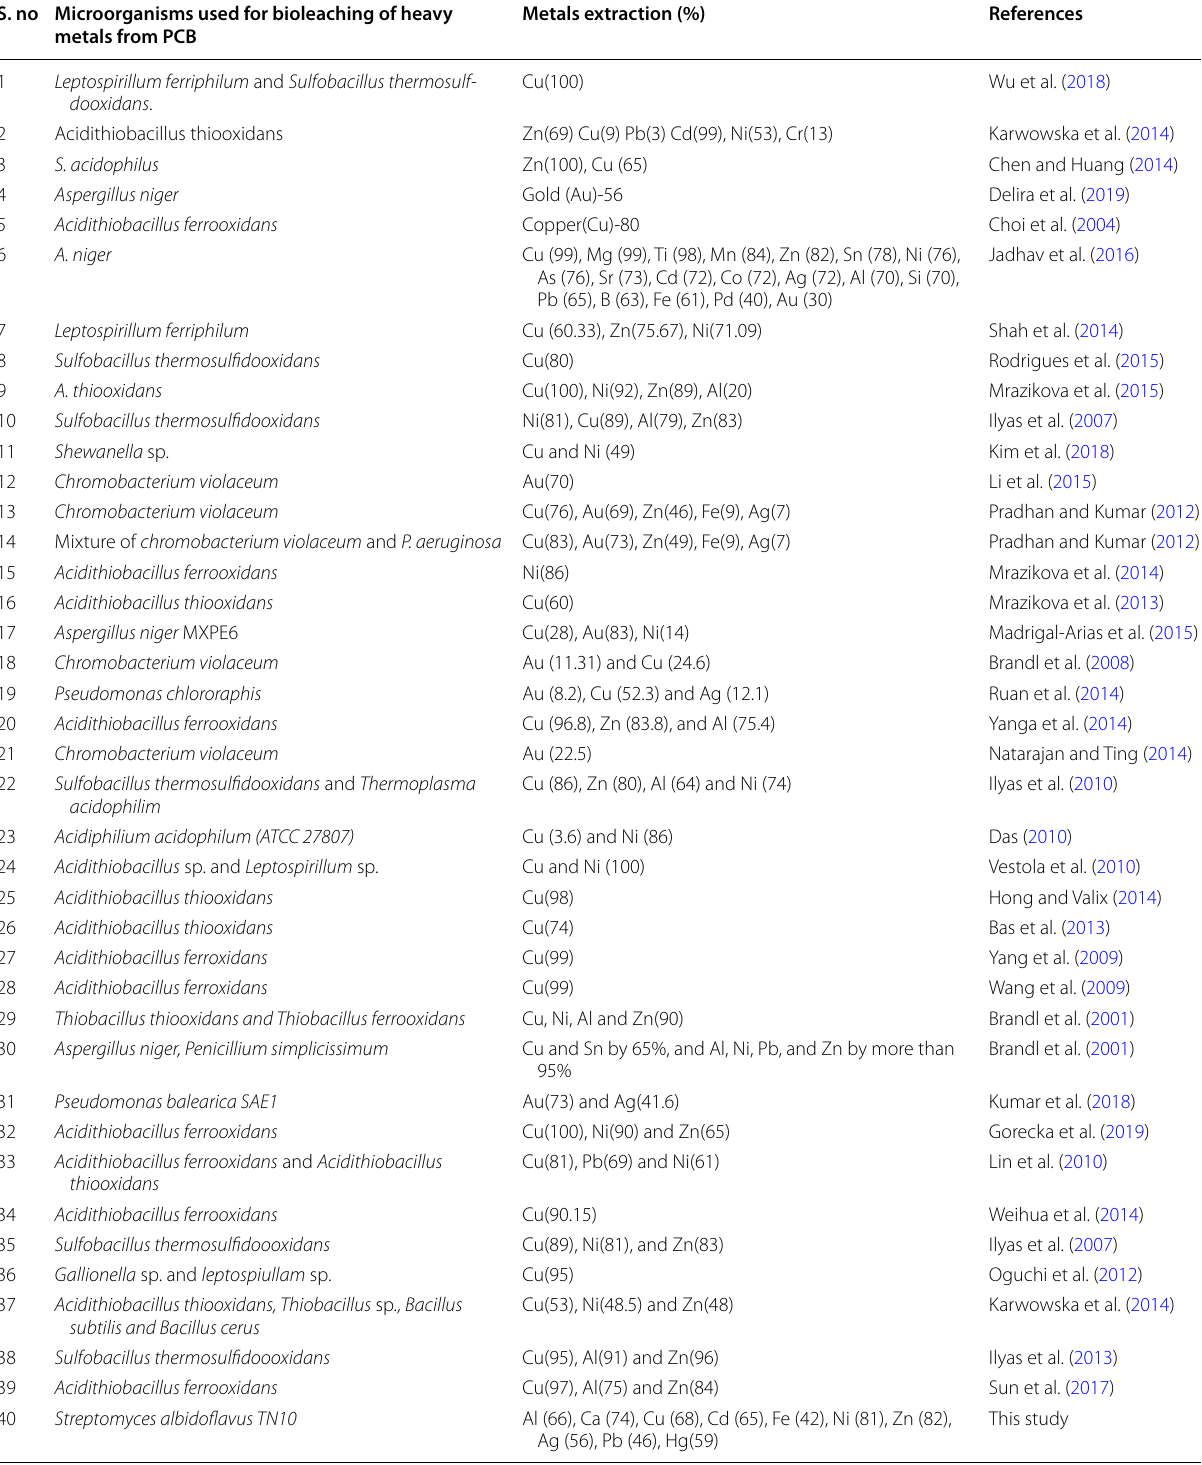
Table 4 Bioleaching of heavy metals from printed circuit board by several microorganisms S. no Microorganisms used for bioleaching of heavy metals from